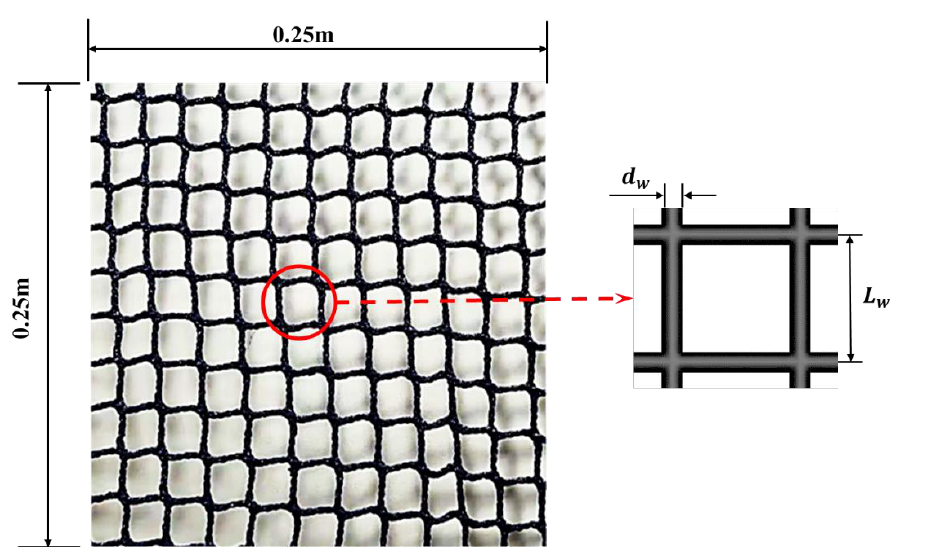
Figure 2. A physical model of the net panel and its geometrical description. Table 1. Parameters of the net panels. ( S n = 2 d w mesh bar